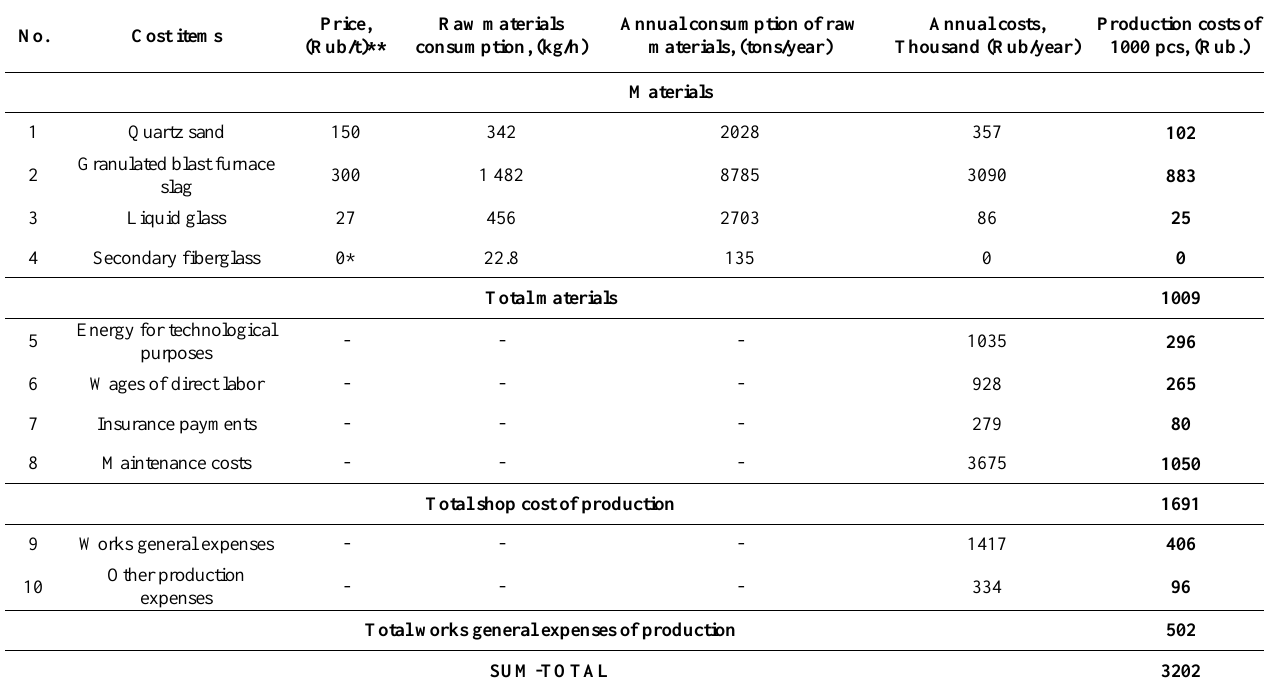
Table 6. Calculation of the production cost of 1000 pcs of lime-sand